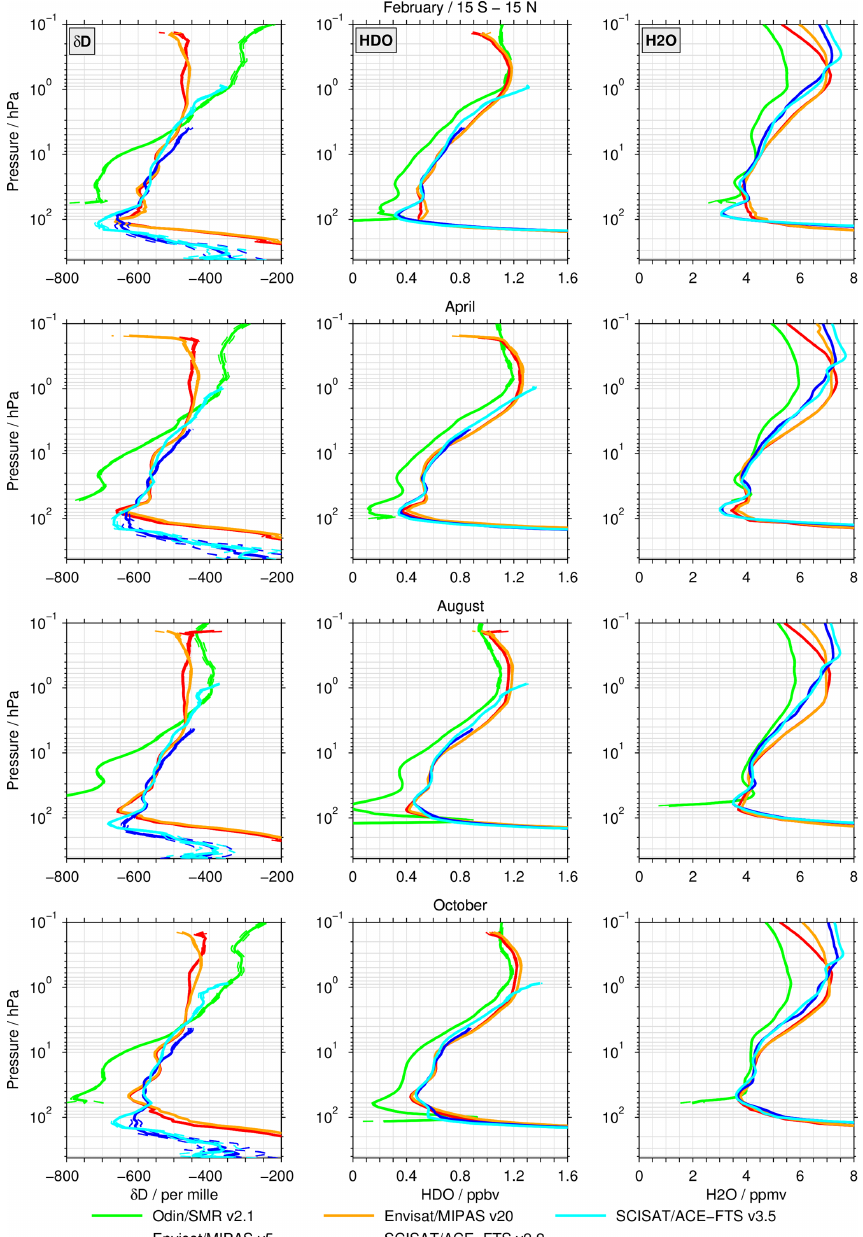
Figure 10. Tropical mean (15 ◦ S–15 ◦ N) profiles for δ D (left column panels), HDO (middle column), and H 2 O (right column panels) for February, April, August, and October given in different